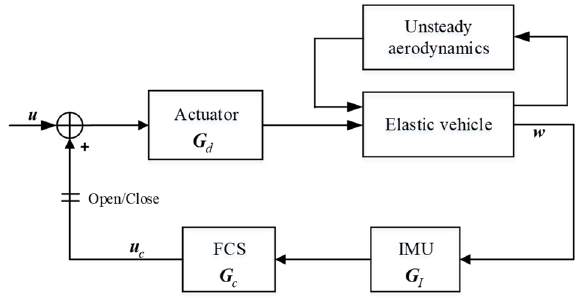
Figure 1. Block diagram of the theoretical ASE system.